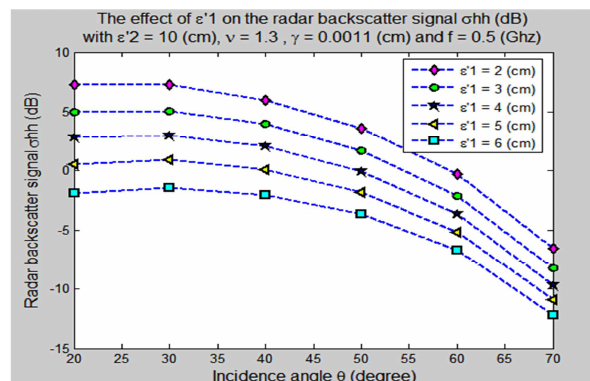
Figure 11. Backscattering coefficient dependence on ε ’1 at HH polarization